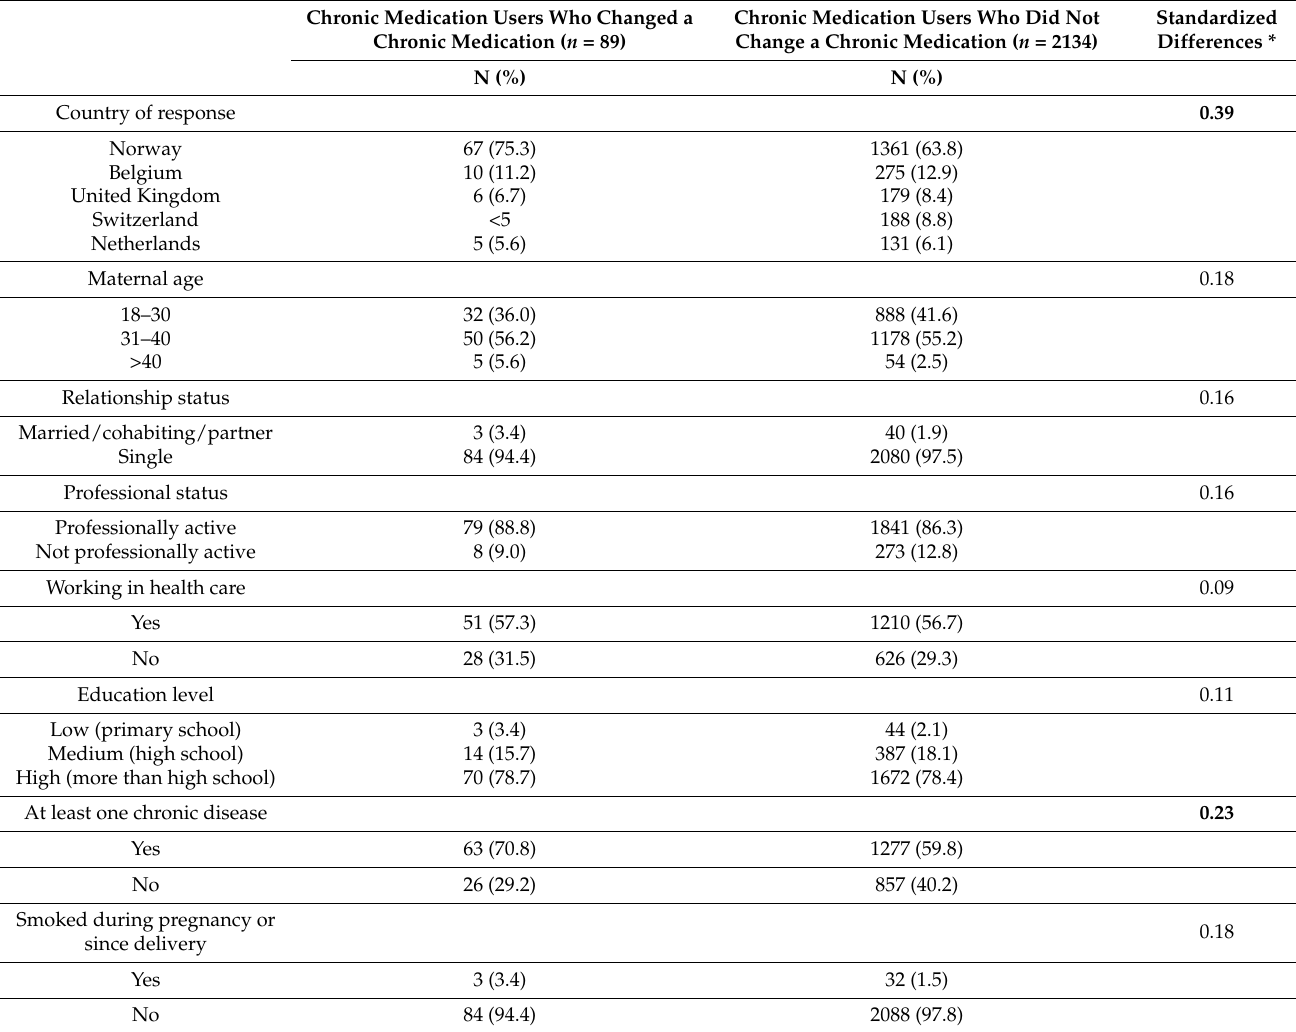
Table 3. Characteristics of chronic medication users ( n = 2223) according to any change in medication use on personal initiative due to the COVID-19